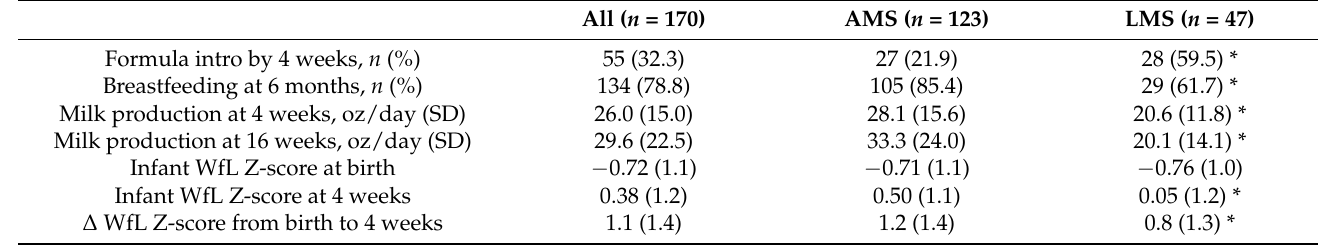
Table 2. Infant weight trajectory and feeding characteristics.